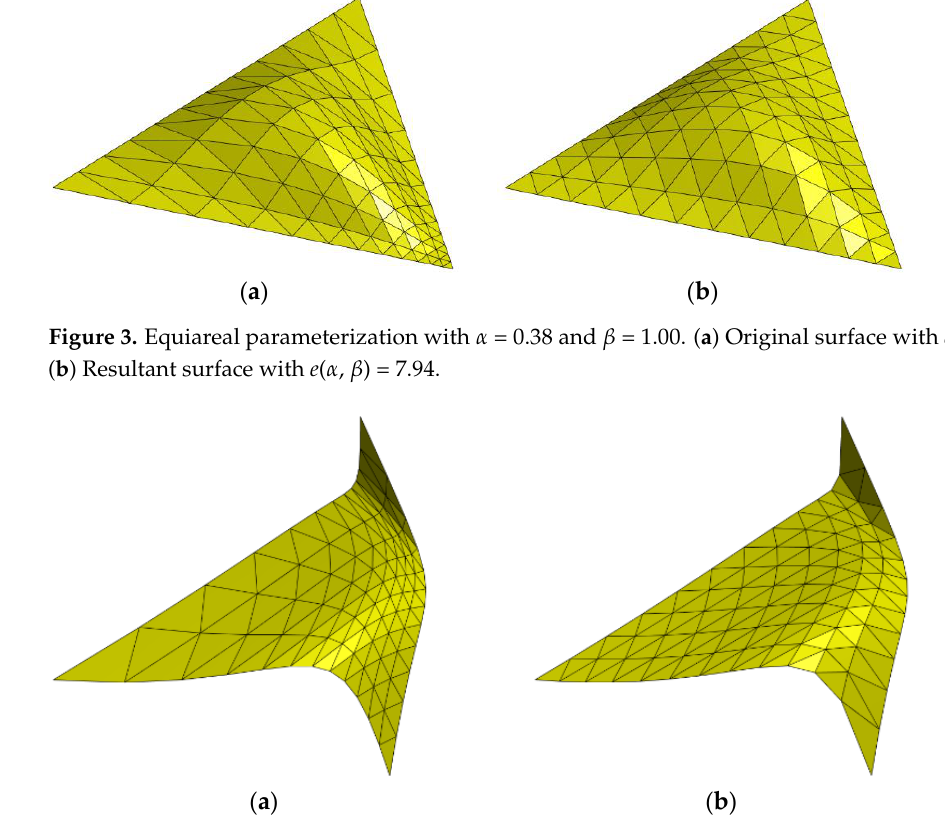
Figure 4. Equiareal parameterization with α = 0.30 and β = 0.36. ( a ) Original surface with e = 22.15. ( b ) Resultant surface with e ( α , β ) = 10.90.